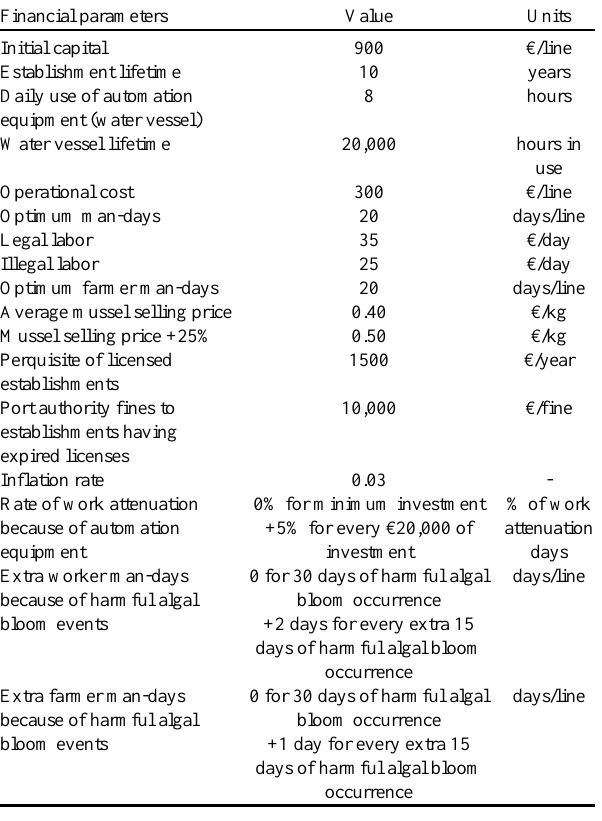
Table 3 . Values and definitions of the financial parameters used in the economic component: the values and approximations made were based on the interview survey implemented in Chalastra.